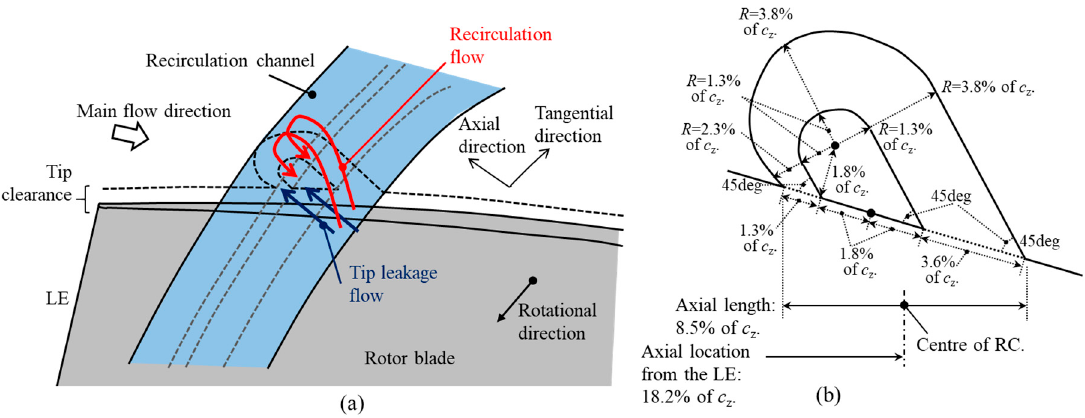
Figure 1. The concept of the self-adjusting passive control technique. ( a ) Conceptual sketch of the recirculation channel (RC) for the axial compressor rotor; ( b ) meridional cross-section of the recirculation channel. All dimensions are normalized by the rotor blade tip chord c z and all axial locations are referenced to the rotor blade tip Leading Edge (LE).